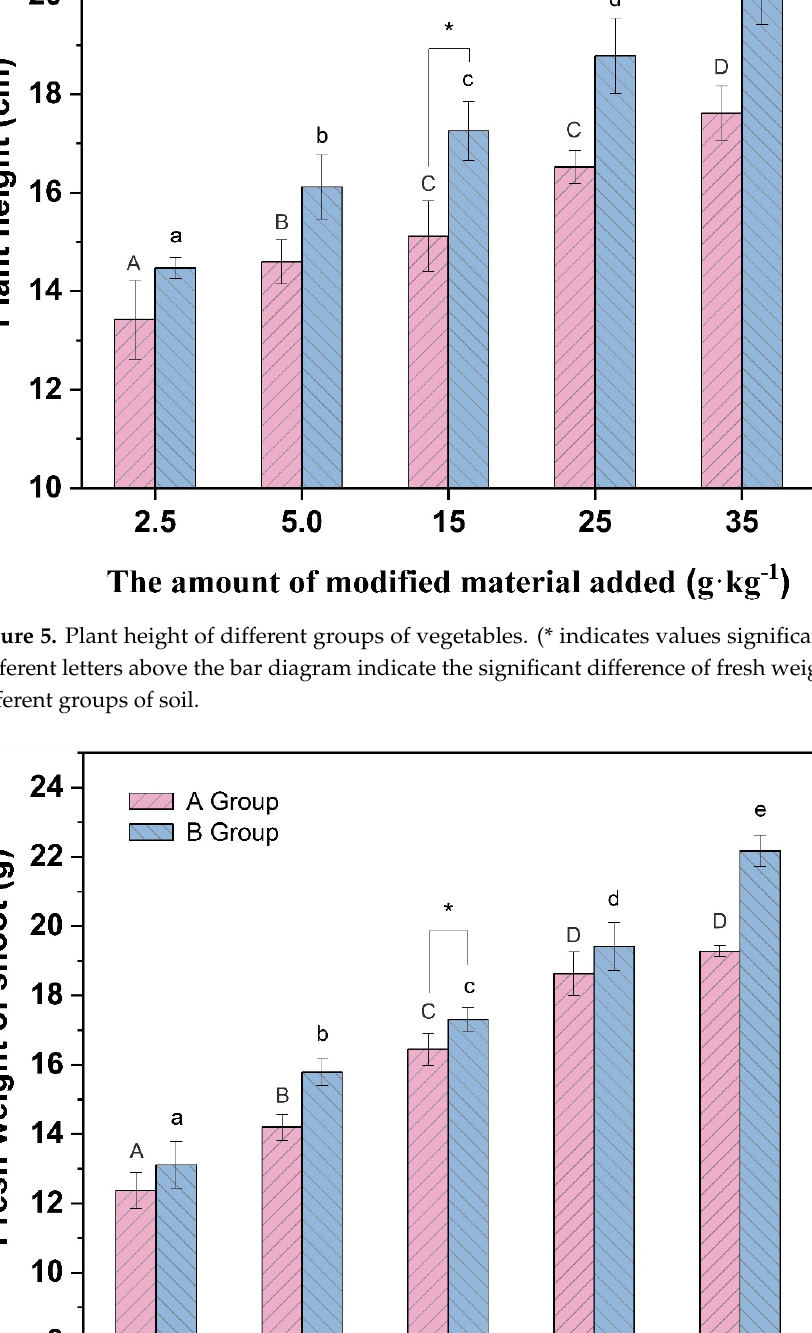
Figure 7. Root fresh weight of different groups of vegetables. (* indicates values significant at p < 0.05). Different letters above the bar diagram indicate the significant difference of fresh weight of shoot in different groups of soil.